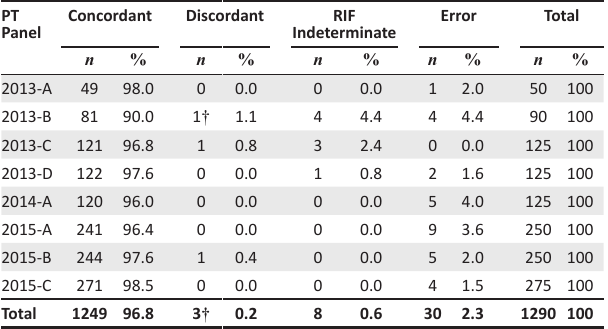
TABLE 1: Accuracy of dried tube specimen Xpert MTB/RIF test results collected during panel validation, 2013–2015, United States Centers for Disease Control and Prevention (Atlanta, Georgia, United States).